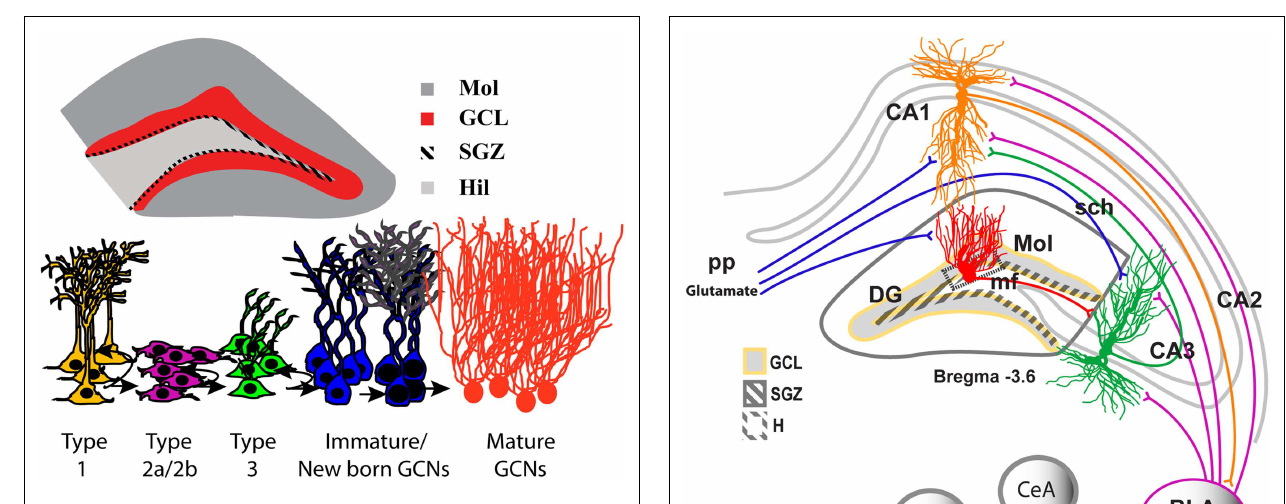
FIGURE 1 | Neurogenesis in the subgranular zone of the hippocampus . Schematic representation of the coronal view of the hippocampus region; magnification of the DG region in a coronal view − 3.6mm from bregma indicating the subregions of the DG and highlighting the neurogenic region; GCL in red and SGZ as the hatched area. DG, dentate gyrus; GCL, granule cell layer; Mol, molecular layer; SGZ, subgranular zone; Hil, hilus. Stages of adult hippocampal neurogenesis are indicated below the schematic of the coronal view of the hippocampus. In the DG, type 1 putative stem-like cells are slowly dividing and rarely label with the commonly used exogenous mitotic marker 5-bromo-2 (cid:48) -deoxyuridine (BrdU) but can be identified via morphology and staining for nestin/GFAP/Sox2. BrdU will label rapidly dividing type 2 and some type 3 cells.Type 3 cells mature and differentiate into immature granule cell neurons and migrate a short distance into the granule cell layer to become granule cell neurons and integrate into the hippocampal circuitry.